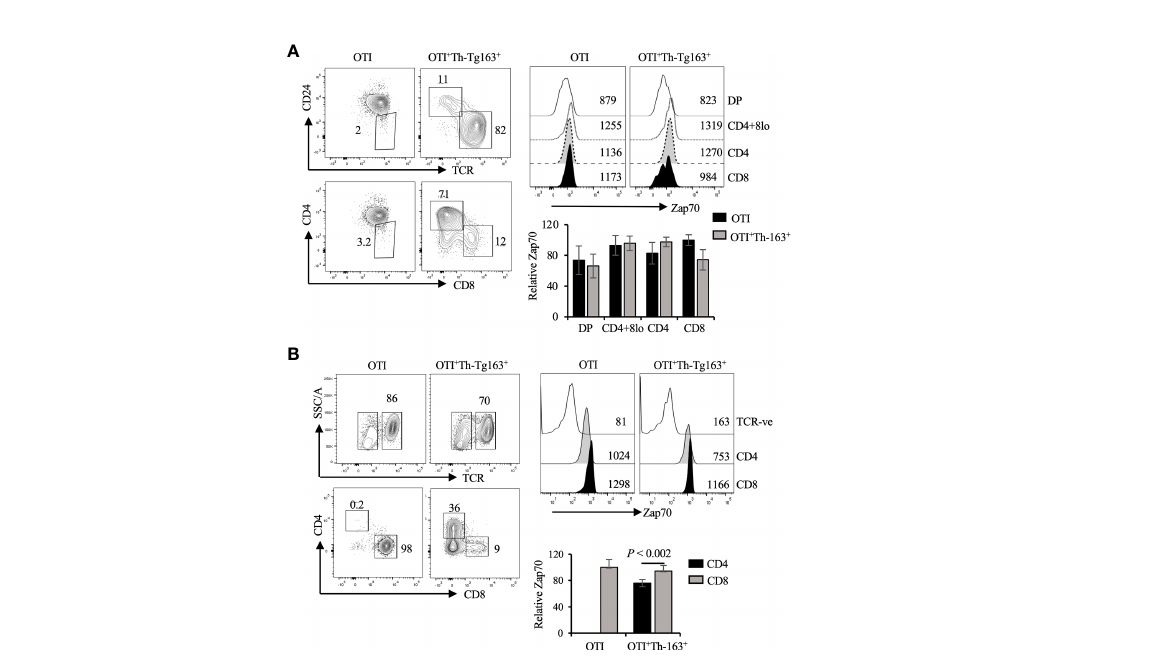
FIGURE 6 | Constitutive Thpok expression does not alter Zap70 expression. (A) CD24/TCR and CD4/CD8 staining of, respectively, total and mature thymocytes and Zap70 histograms for the indicated thymic subsets from OTI and OTI + Th-163 + mice is shown. Bar graph shows comparison of relative Zap70 MFI in the indicated thymic subsets from OTI mice expressing or not Th-163 transgene. (B) shows TCR and CD4/CD8 staining of splenic T cells and Zap70 expression in CD4 and CD8 T cells from OTI and OTI + Th-163 + mice. Bar graph shows relative Zap70 expression in CD4 and CD8 T cells from the indicated mice (n>4 mice in three independent experiments). Frequency of cells and MFI values are shown in FACS plots and histograms.